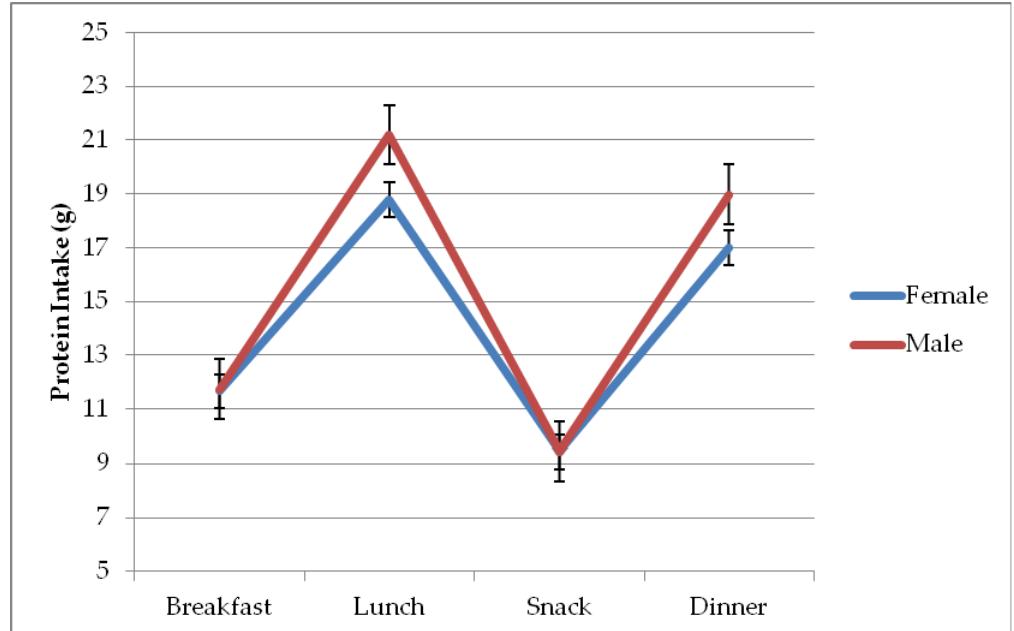
Figure 3. Protein intake of participants in each main meal by sex.